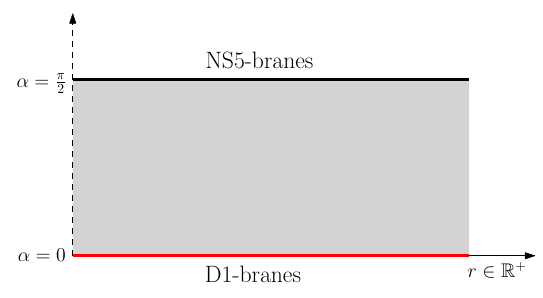
Figure 4 . In(cid:12)nite strip associated to the NATD solution.